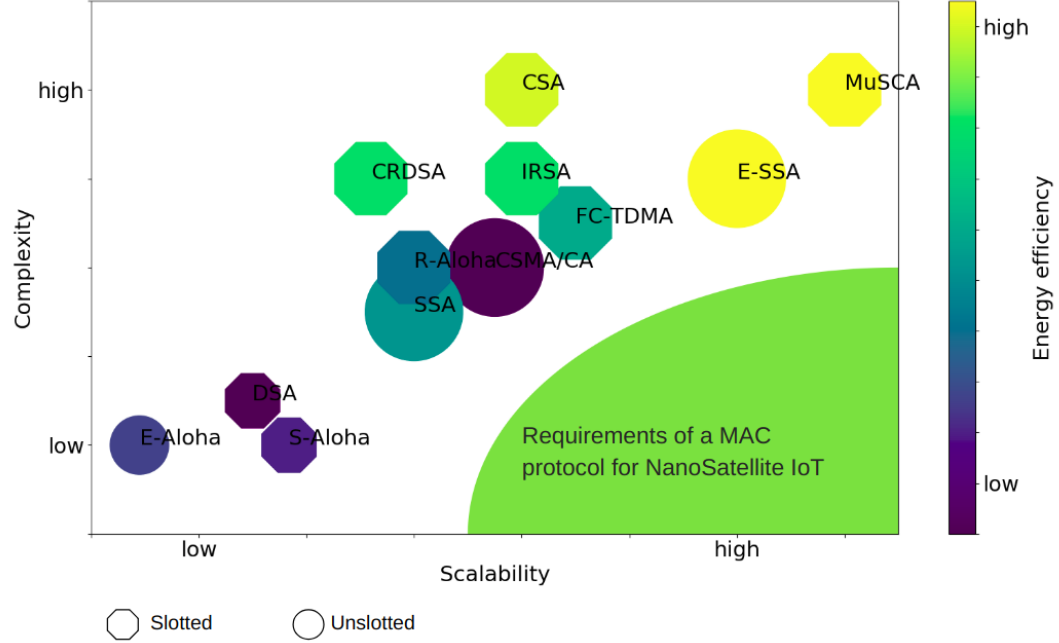
Figure 14. A visual comparison of the reviewed medium access control (MAC) protocols in the context of nanosatellite IoT